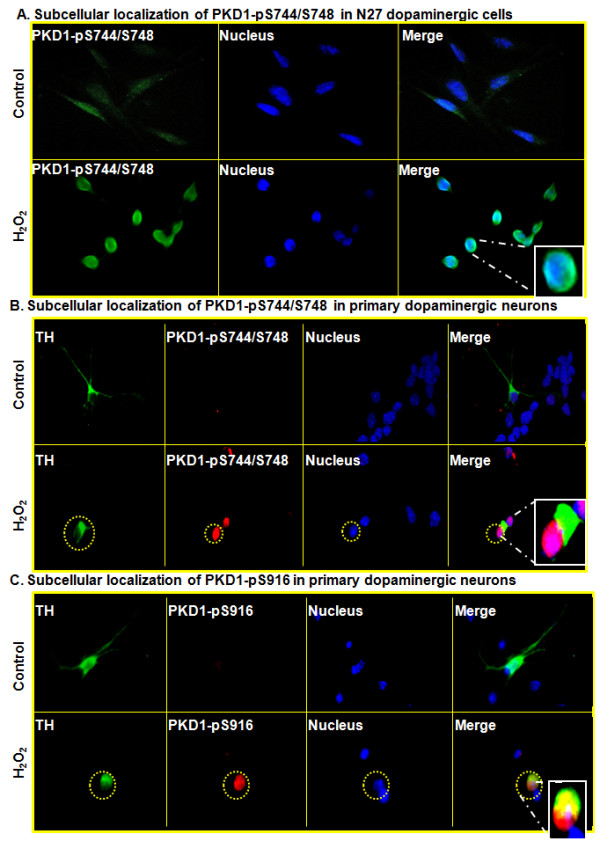
Activated PKD1 translocates to nucleus during H2O2 -induced oxidative stress. Immunofluorescence analysis of N27 dopaminergic cells stained for activated PKD1 using fluorescence microscopy during H2O2 exposure show translocation to nucleus. PKD1pS744/S748 - Green, Nucleus - Blue. Nuclei were stained with Hoechst dye (A). Immunofluorescence analysis of primary dopaminergic neurons staining for TH obtained from the mouse substantia nigral region shows translocation of activated PKD1 to the nucleus during H2O2 exposure.TH-Green, PKD1pS744/S748 - Red, Nucleus - Blue, Merge - Pink. Nuclei were stained with Hoechst dye (B). Primary dopaminergic neurons staining for TH show presence of PKD1pS916 in both cytosol and nucleus during H2O2 exposure. TH - Green, PKD1pS916- Red, Nucleus - Blue, Pink - Merge in nucleus, yellow -Merge in cytosol. Nuclei were stained with Hoechst dye (C).